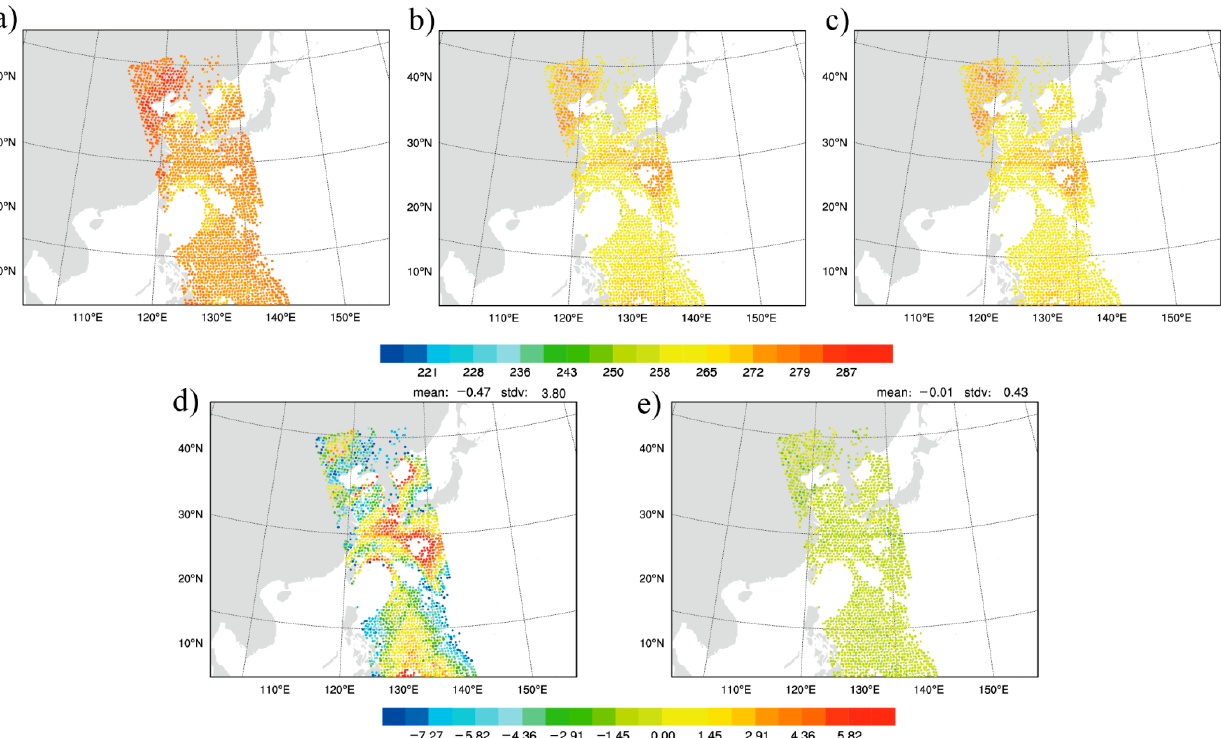
Figure 6. The distribution of Tb (units: K) for: ( a ) the background, ( b ) the analysis, ( c ) the observation, ( d ) the observation minus the background with BC (bias correction), and ( e ) the observation minus the analysis, valid at 0600 UTC 8 August 2019.